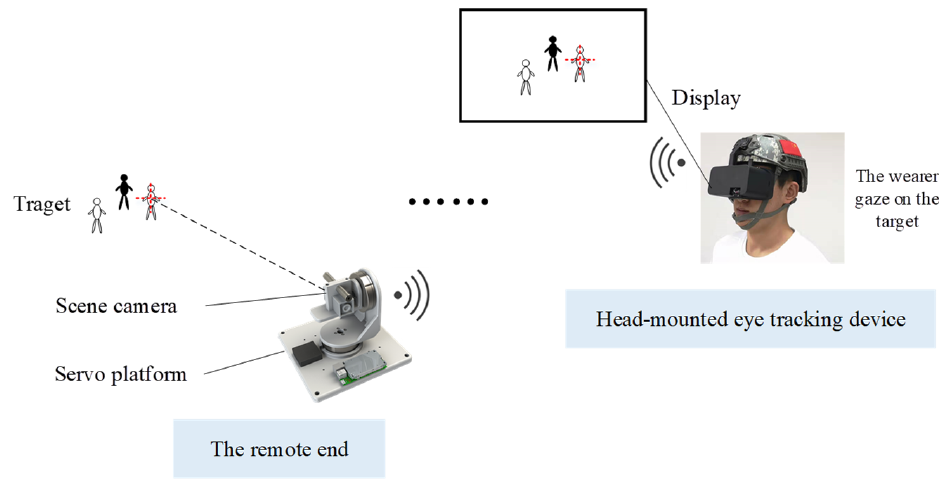
Figure 6. Eye-tracking device.